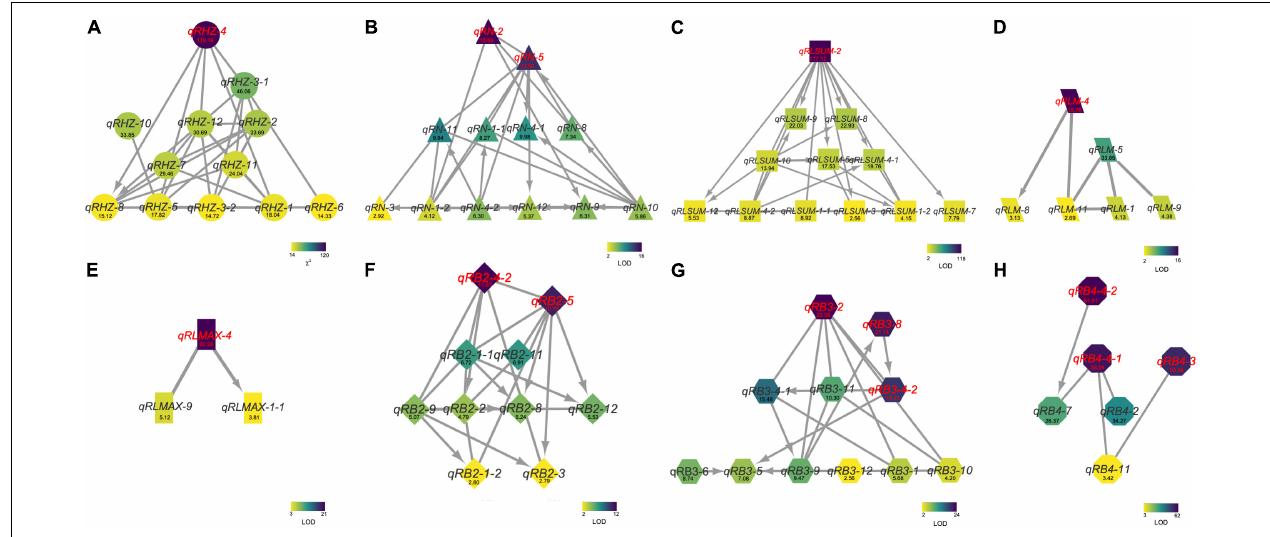
FIGURE 5 | The genetic networks for Rhz (A) , RN (B) , RLsum (C) , RLmean (D) , RLmax (E) , RB2 (F) , RB3 (G) , and RB4 (H) . A line between two nodes indicates that these two nodes are a pair of E-loci (A) or E-QTLs (B–H) . An arrow between two nodes represents a hierarchical relationship between this node pair, with the node at the arrowhead being regulated by the other node of the pair. Numbers are Chi square values (A) or LOD values (B–H)